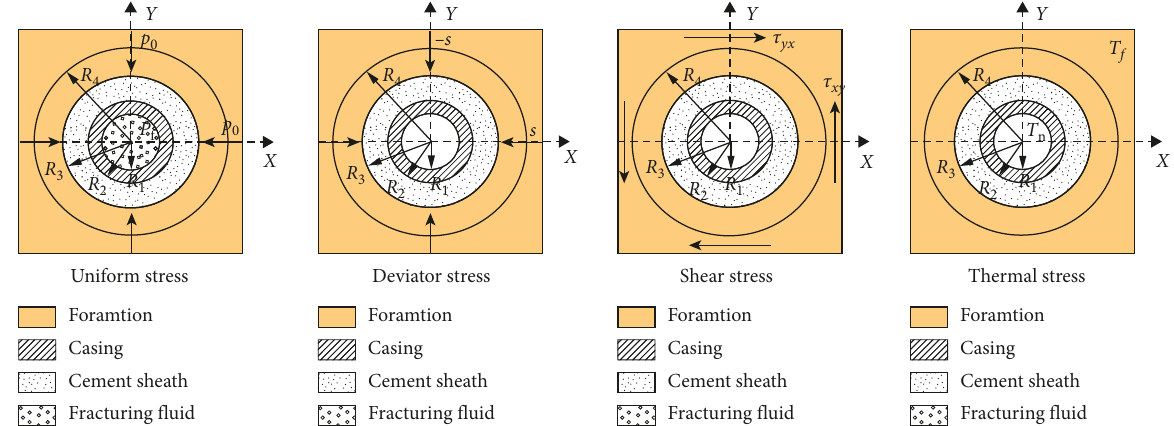
Figure 5: Stress decompositions. Inner casing pressure, P